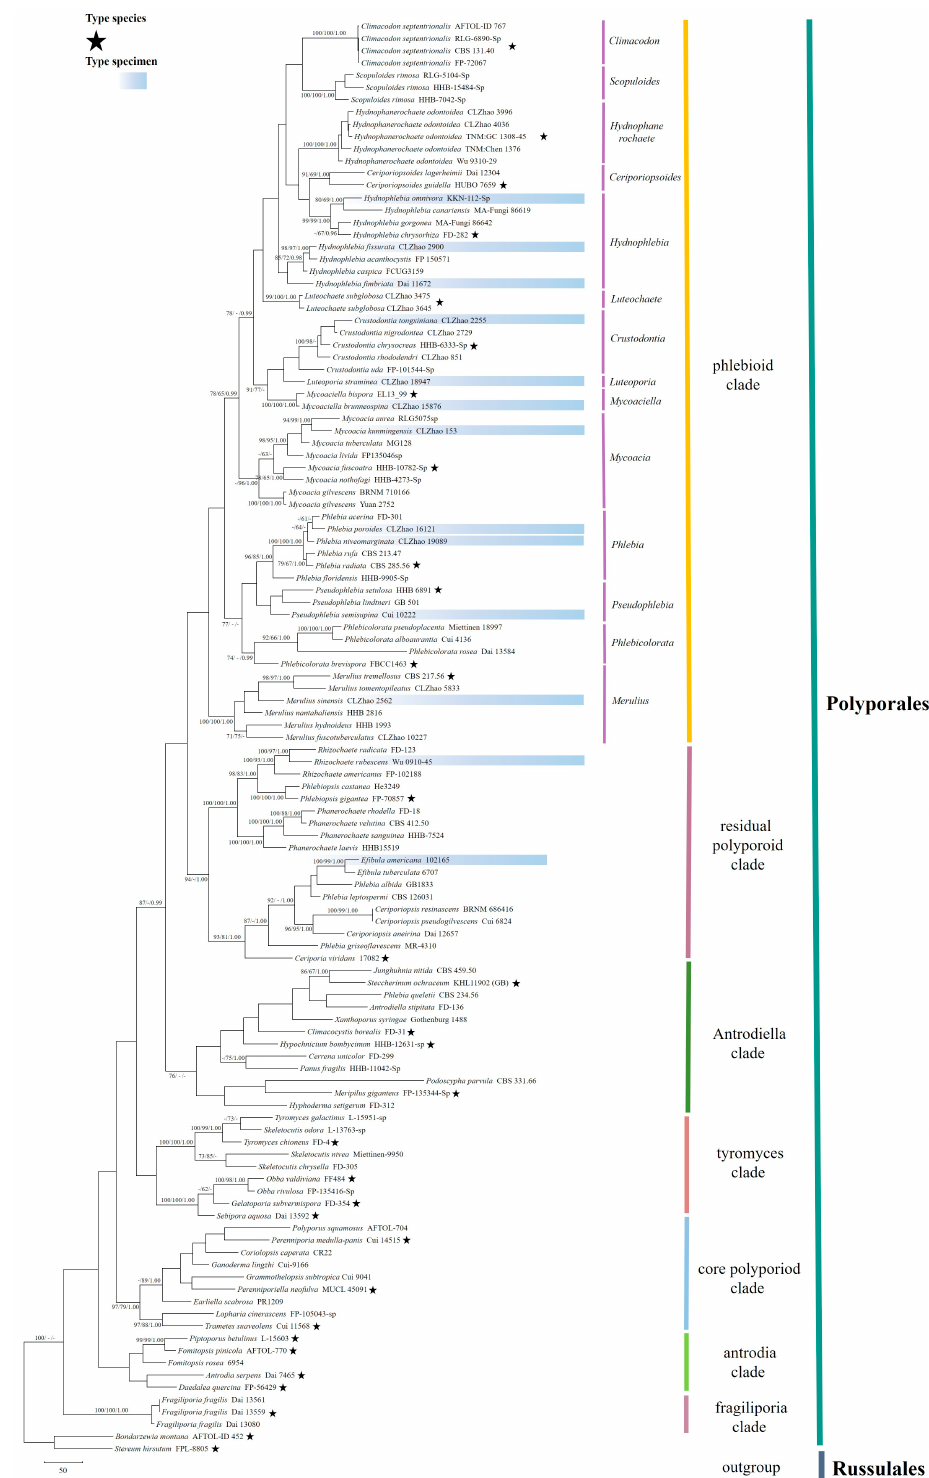
Figure 1. Maximum Parsimony strict consensus tree illustrating the phylogeny of Phlebia species and related genera in the order Polyporales based on ITS + nLSU sequences. Branches are labeled with BS > 70%, BT > 50% and BPP > 0.95, respectively. Clade names follow the previous study by Justo et al. [38]. The asterisks represent the type species.